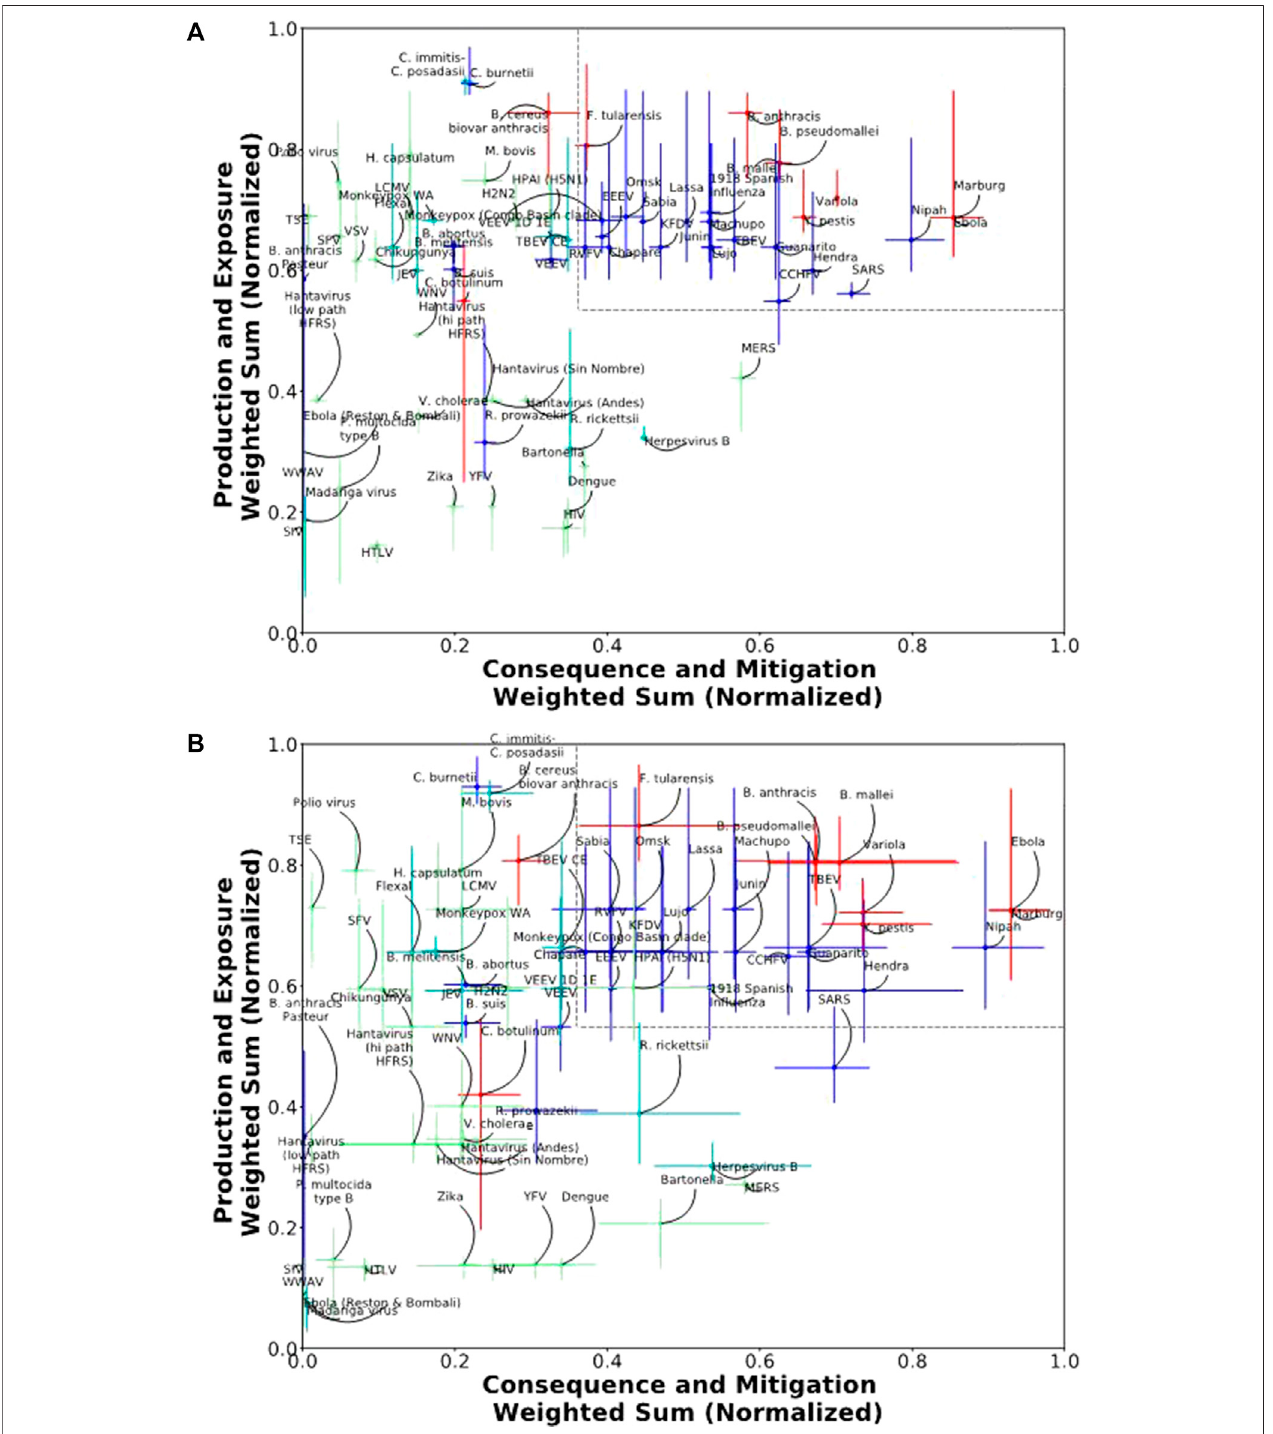
FIGURE 4 | Two-dimensional plot of normalized median scores with error bars (5th and 95th percentiles) for (A) 5/4/6 grouping results and (B) 3/3/9 grouping results.